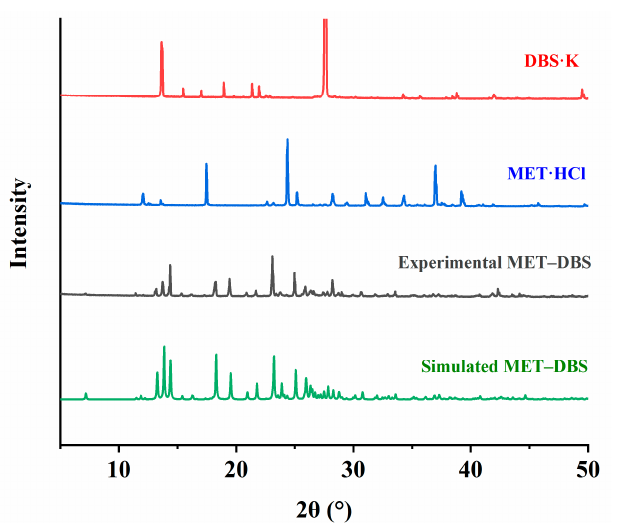
Figure 5. Powder X-ray diffraction patterns of DBS · K, MET · HCl, and MET–DBS (experimental and simulated).